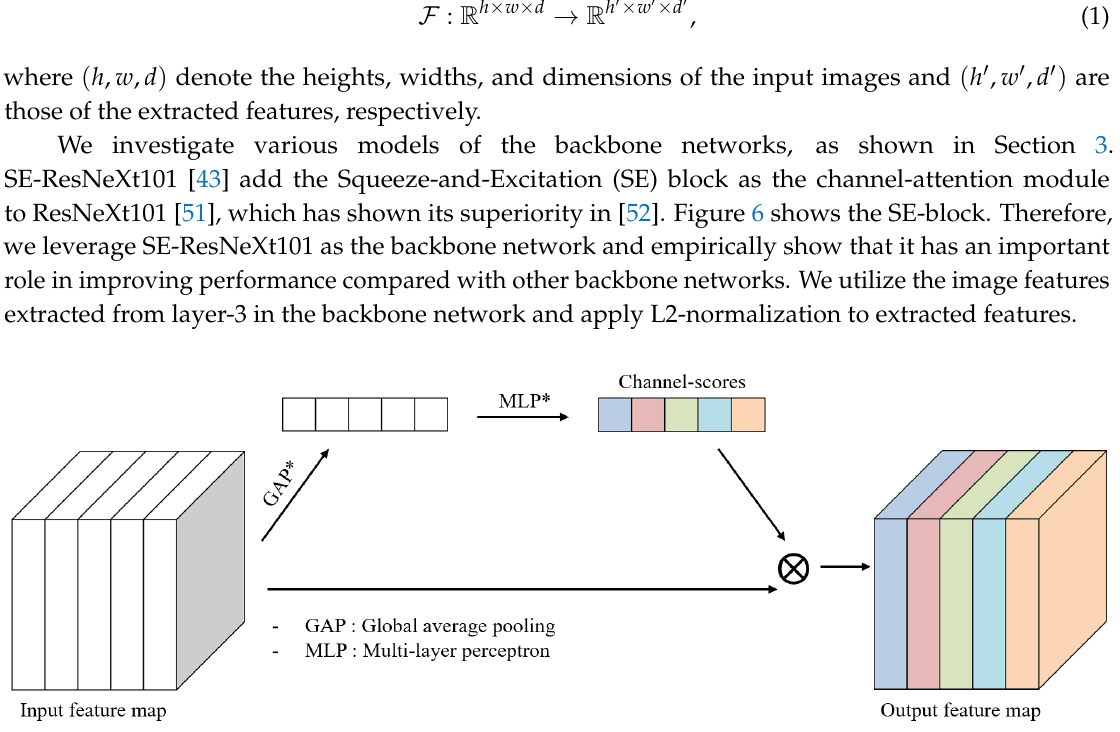
Figure 6. Squeeze-and-Excitation (SE) block. The input feature map is applied by global average pooling (GAP), followed by a multi-layer perceptron (MLP). The input feature map is elementwise multiplied by the